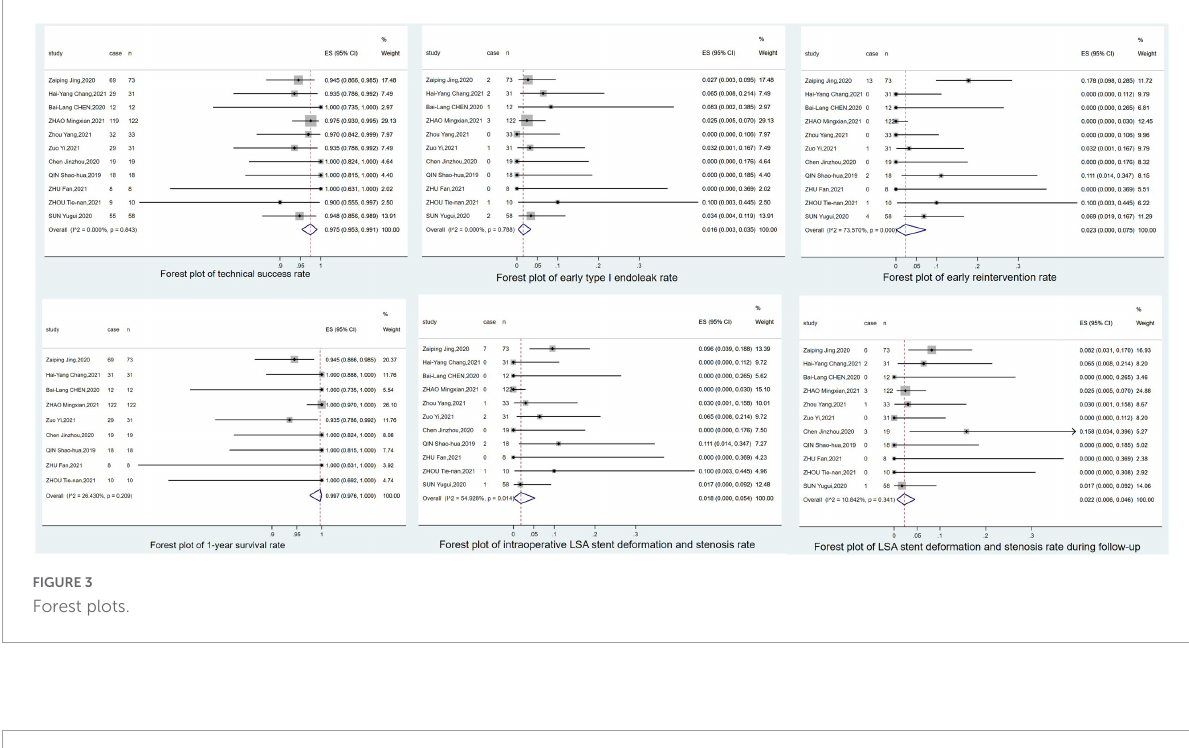
FIGURE3 Forest plots.